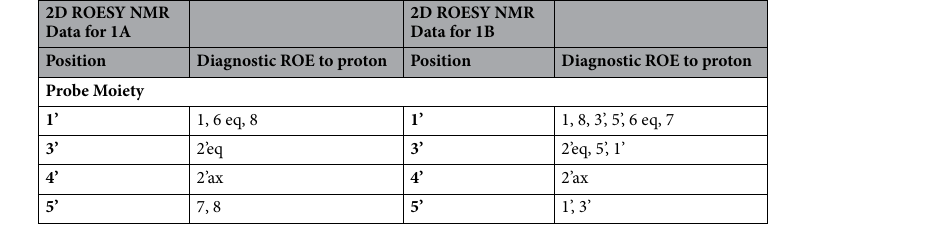
Table 3. Diagnostic ROE to proton for 1A compared to 1B.